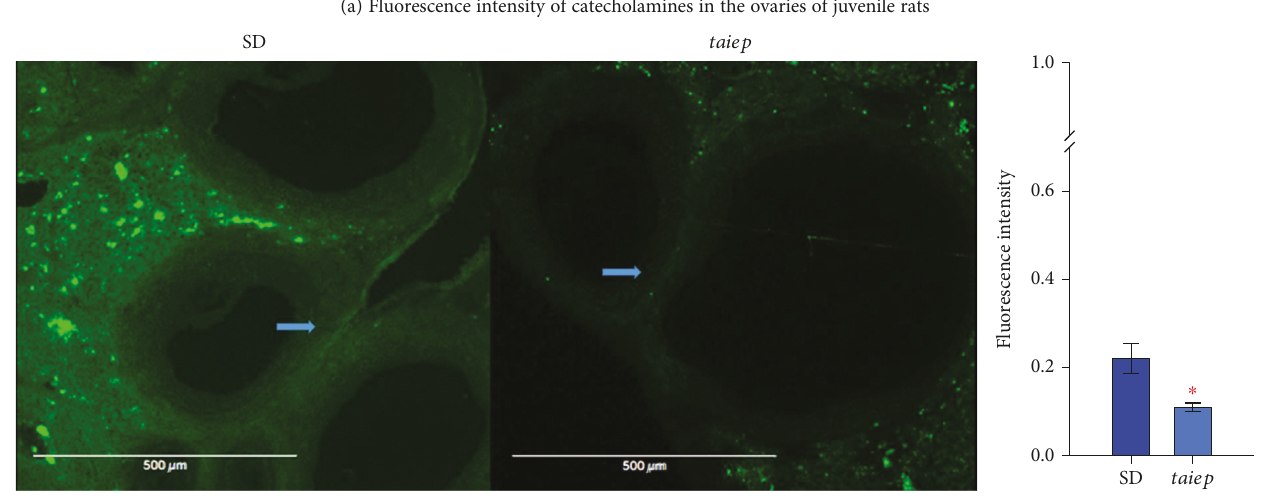
Figure 5: Fluorescence intensity of catecholamines in the ovaries of juvenile and adult Sprague – Dawley and taiep rats. (a) Immunohistochemistry of an ovary slice of juvenile Sprague – Dawley and taiep rats; arrows indicate the location of the fl uorescent around the follicle; the bar graph shows fl uorescence intensity. The error bars represent the standard error of measurements for 30 sections of ovaries by group. (b) Immunohistochemistry of an ovary slice of adult Sprague – Dawley and taiep rats; arrows indicate the location of the fl uorescents, and the bar graph shows fl uorescence intensity. SD: Sprague – Dawley. The error bars represent the standard error of measurements for 30 sections of ovaries by group. ∗ p ≤ 0 01 Student ’ s t